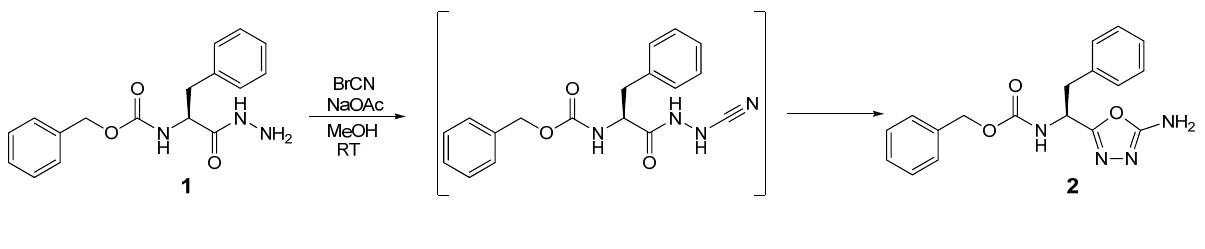
Figure 1. Synthesis of 2-amino-1,3,4-oxadiazole 2